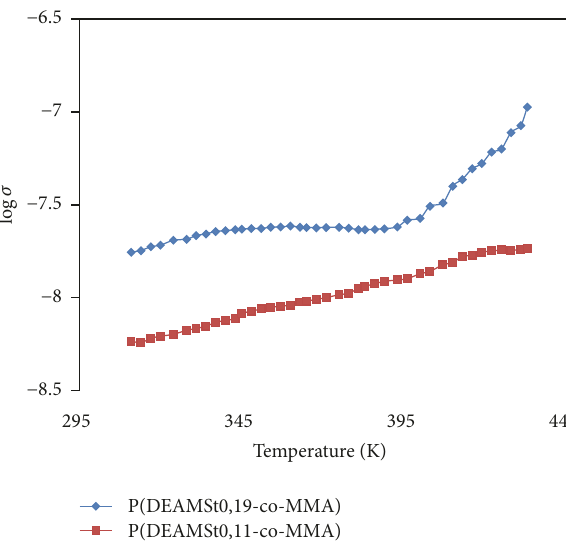
Figure 18: The graph of the conductivity (log 𝜎 ) change with temperature for P(DEAMSt0.11-co-MMA) and P(DEAMSt0.19-co-